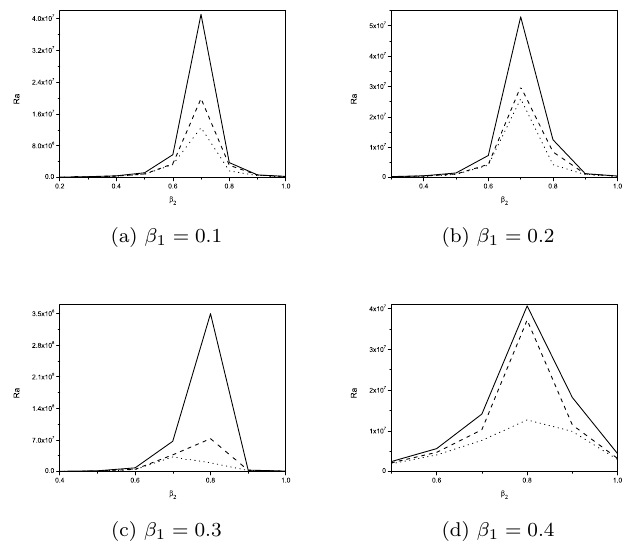
Figure 2. Visual representation of linear instability (solid line) and generalized energy method (dashed line) and weighted energy method (doted line)thresholds, with critical Rayleigh number plotted against β 2 , for R c =